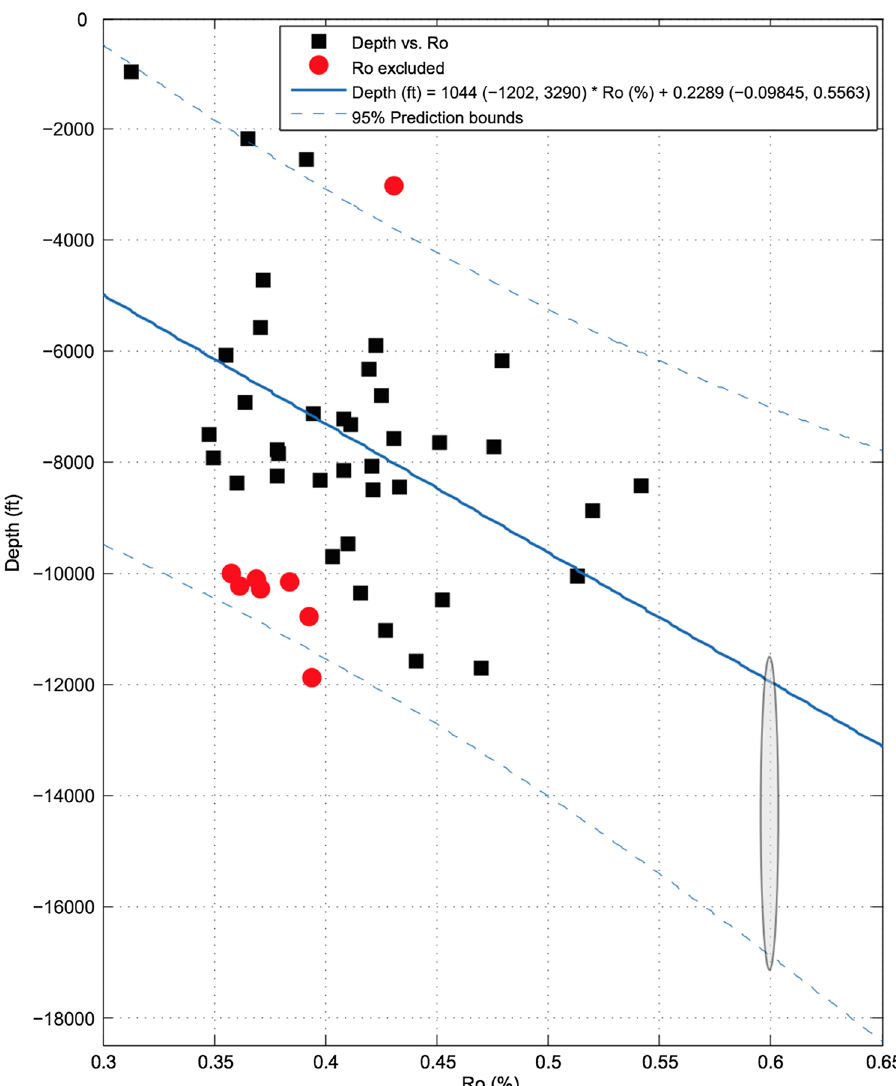
Fig. 8 Linear regression of depth versus Ro (%) with confi- dence bounds of 95%, showing the depth up to approximately 17,000 feet (ellipse) where is expecting that the potential source rock will enter into the generation window for Tumaco Basin,